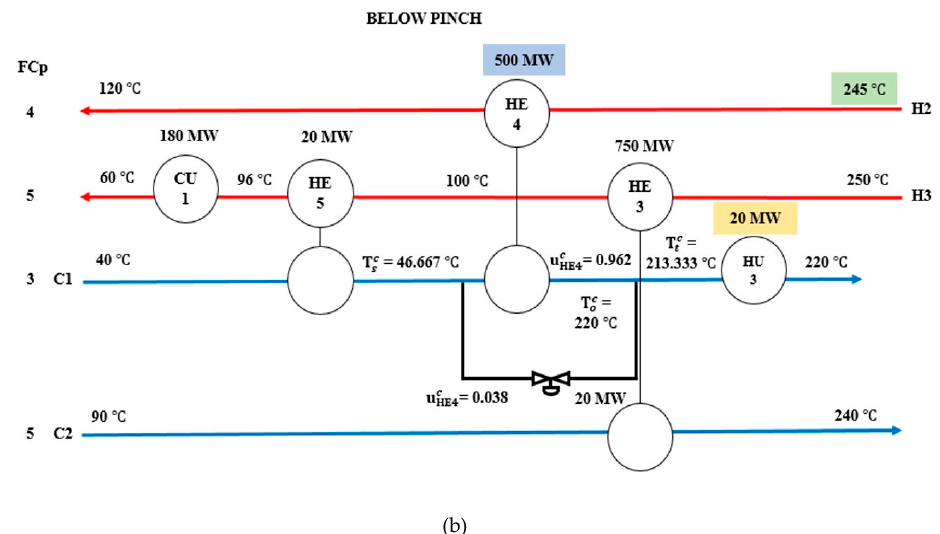
Figure 6. ( a ) HEN design with nominal T S for hot stream H2; ( b ) HEN design with T S decrease by 5 ℃ for hot stream H2.